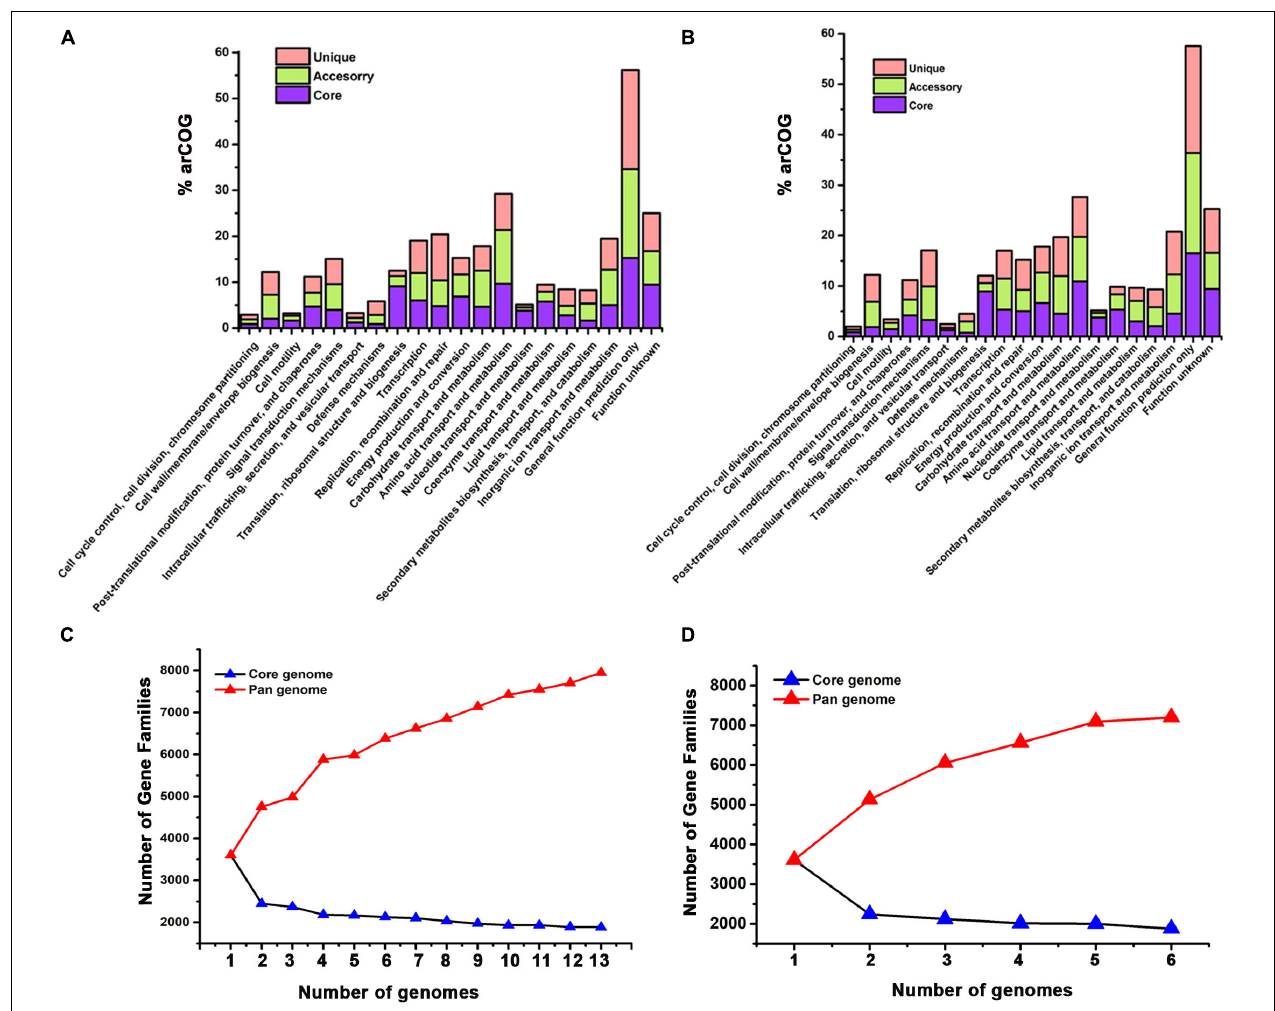
FIGURE 2 | Archaeal clusters of orthologous groups (arCOG) analysis of the genomes. Comparison of the COG distribution between the core, accessory and unique genes of the (A) thirteen species belonging to genus Haloferax including wsp1 and (B) four species belonging to genus Halogeometricum including wsp3 and wsp4 have been analyzed using default parameters of BPGA pipeline. The arCOG categories are indicated on the X -axis and the percentage of the genes present in each category of the arCOG classes is indicated on the Y -axis. (C,D) The Core and pangenome plots of genera Haloferax and Halogeometricum , respectively. Red and blue colored lines indicate the change in the number of pangenome and core genome gene groups added sequentially to the